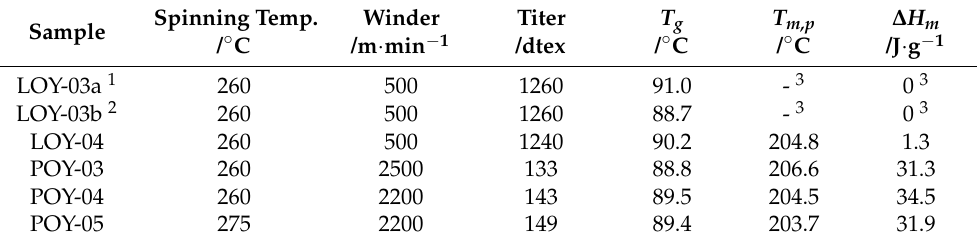
Table 3. Summary of PEF LOYs/POYs, their spinning temperatures, their titers, and their thermal characteristics, as determined by DSC; the numbers in the yarn nomenclature refer to the respective PEF-charge, and the nomenclature of samples is declared in detail in section S1.